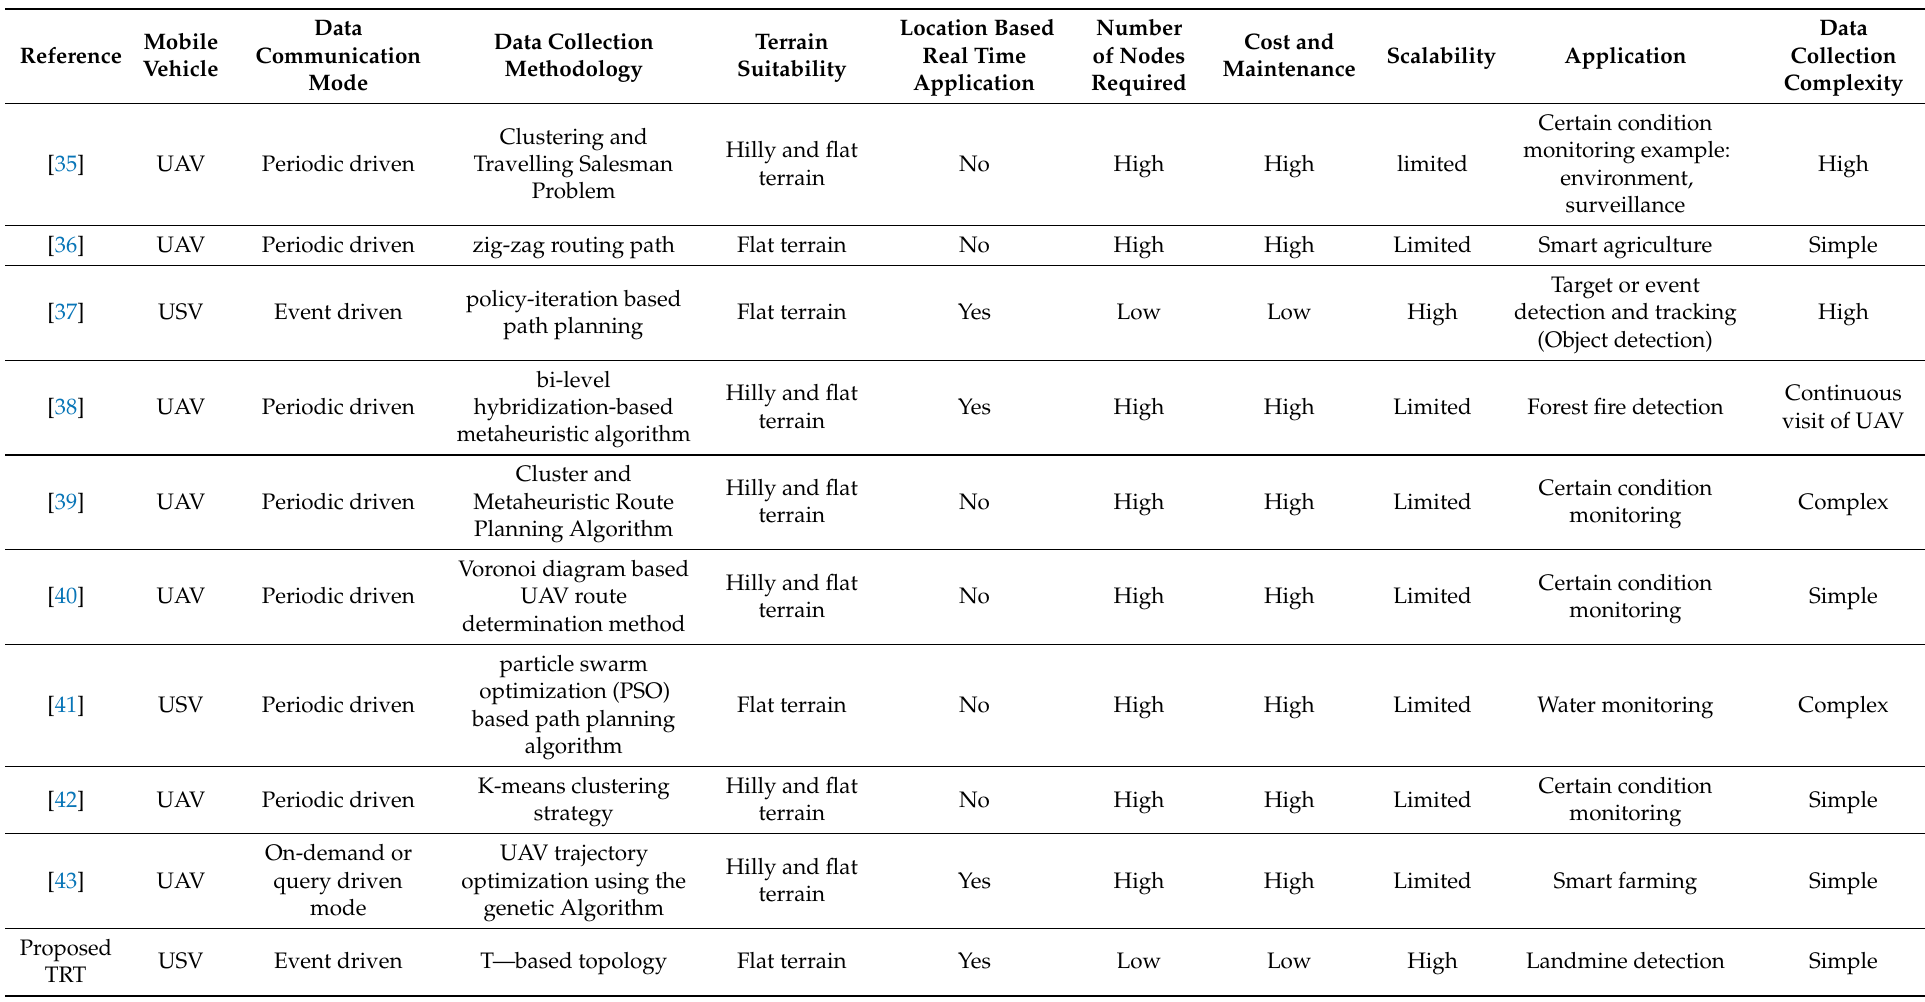
Table 2. Comparison of existing methodology with the proposed